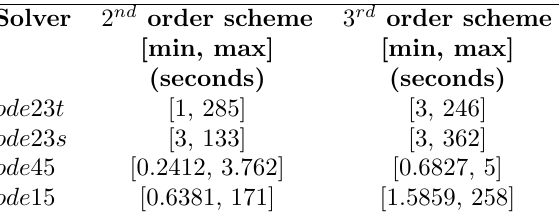
Table 3: Computational time with variable step-length MATLAB solvers for the 2 nd and the 3 rd order KP scheme.